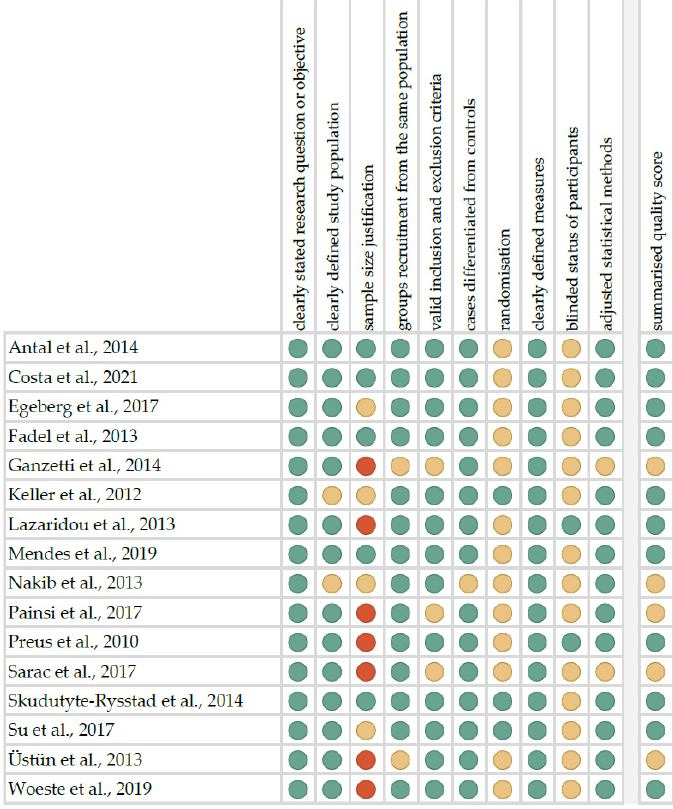
Figure 1. Quality assessment, including the main potential risk of bias (risk level: green—low, yellow—unspecified, red—high; quality score: green—good, yellow—intermediate, red—poor) [33– 35,40–52].